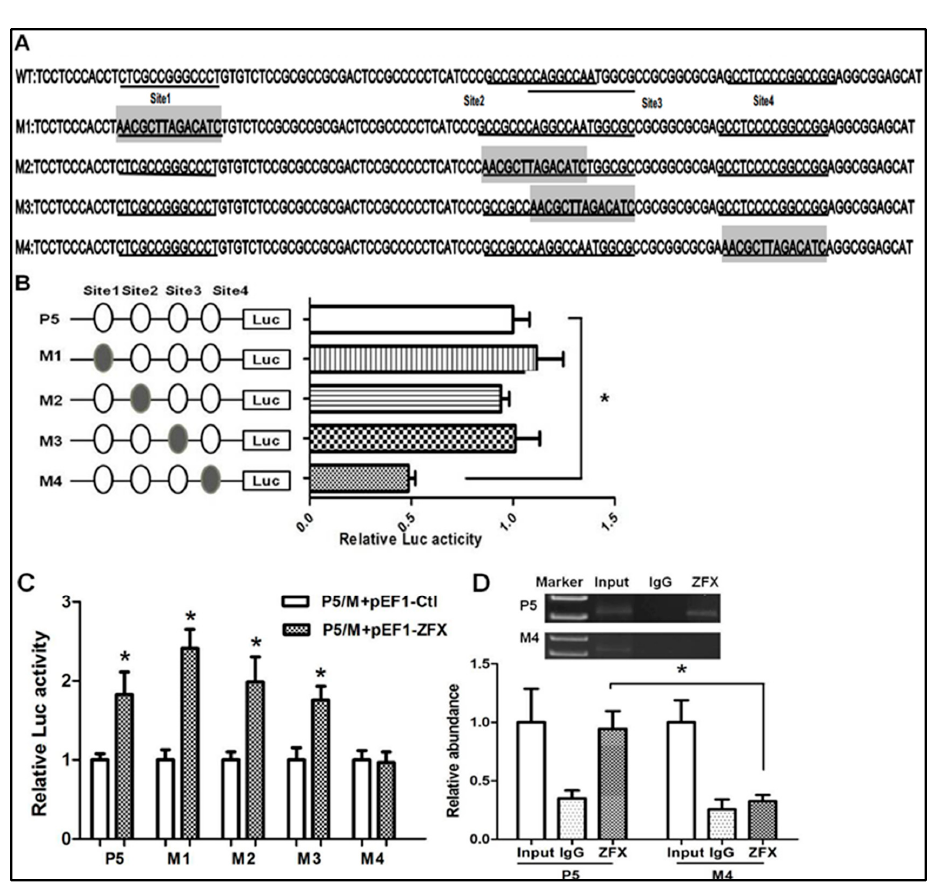
Figure 4. Mutagenesis analysis of putative ZFX-binding sites in SET transcript 2 promoter. ( A ) Locations and sequences of the four ZFX putative binding sites. Note the overlapped Site2 and Site3. Mutated sites, designated as M1–M4, were marked with shadows; ( B ) The left part